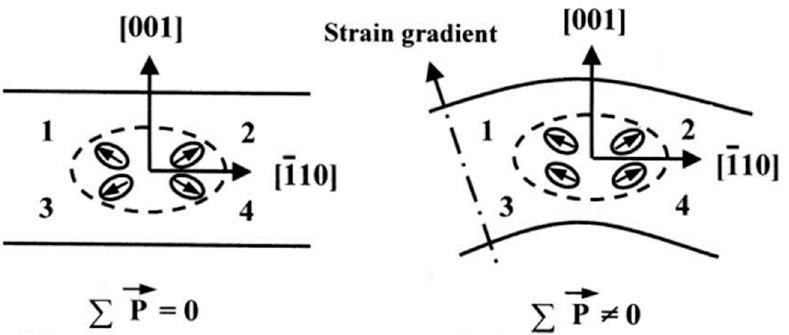
Figure 11. The orientation of nanodomains in relaxor ferroelectrics before and after applying a strain gradient. Reprinted with permission from [8]. Copyright 2001 AIP Publishing .